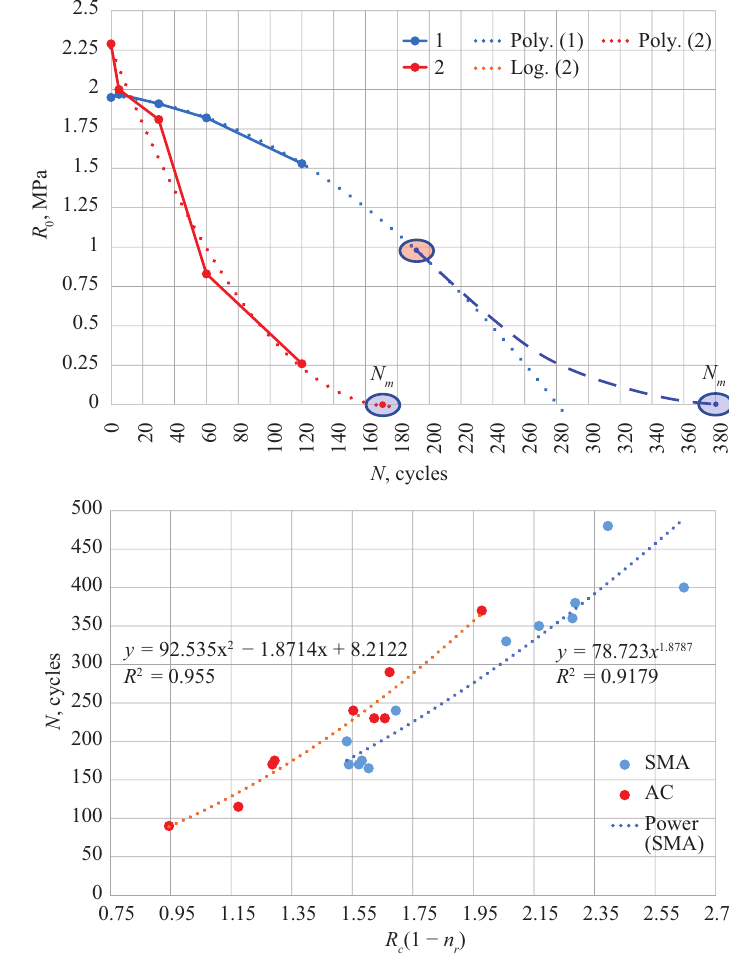
Figure 2. Features of determining the maximum number of freeze-thaw cycles: a) extrapolation diagram; b) dependence between the structural asphalt concrete features and a limit number of cycles to complete